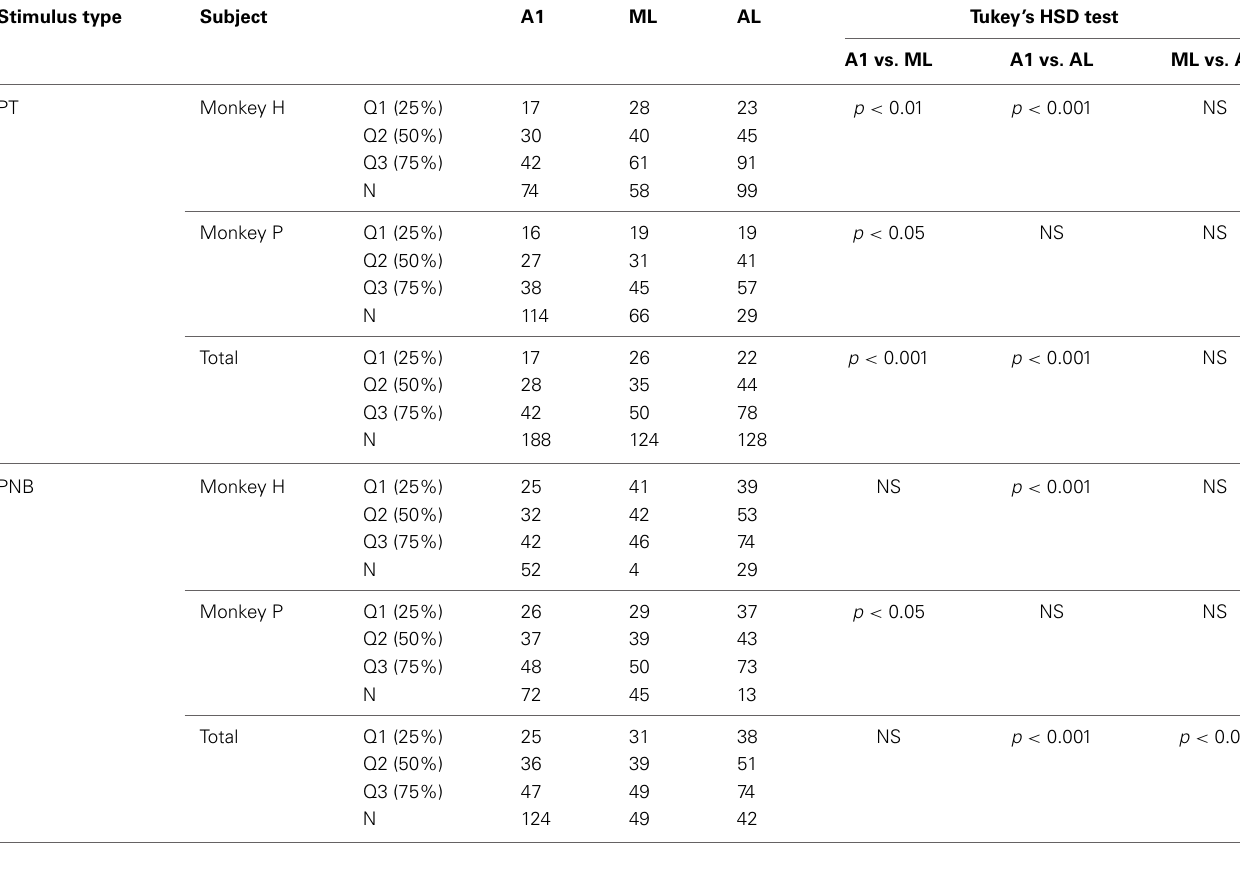
Table 2 | Minimum latencies to pure tones (PT) and pink noise bursts (PNB) in different subfields of auditory cortex.